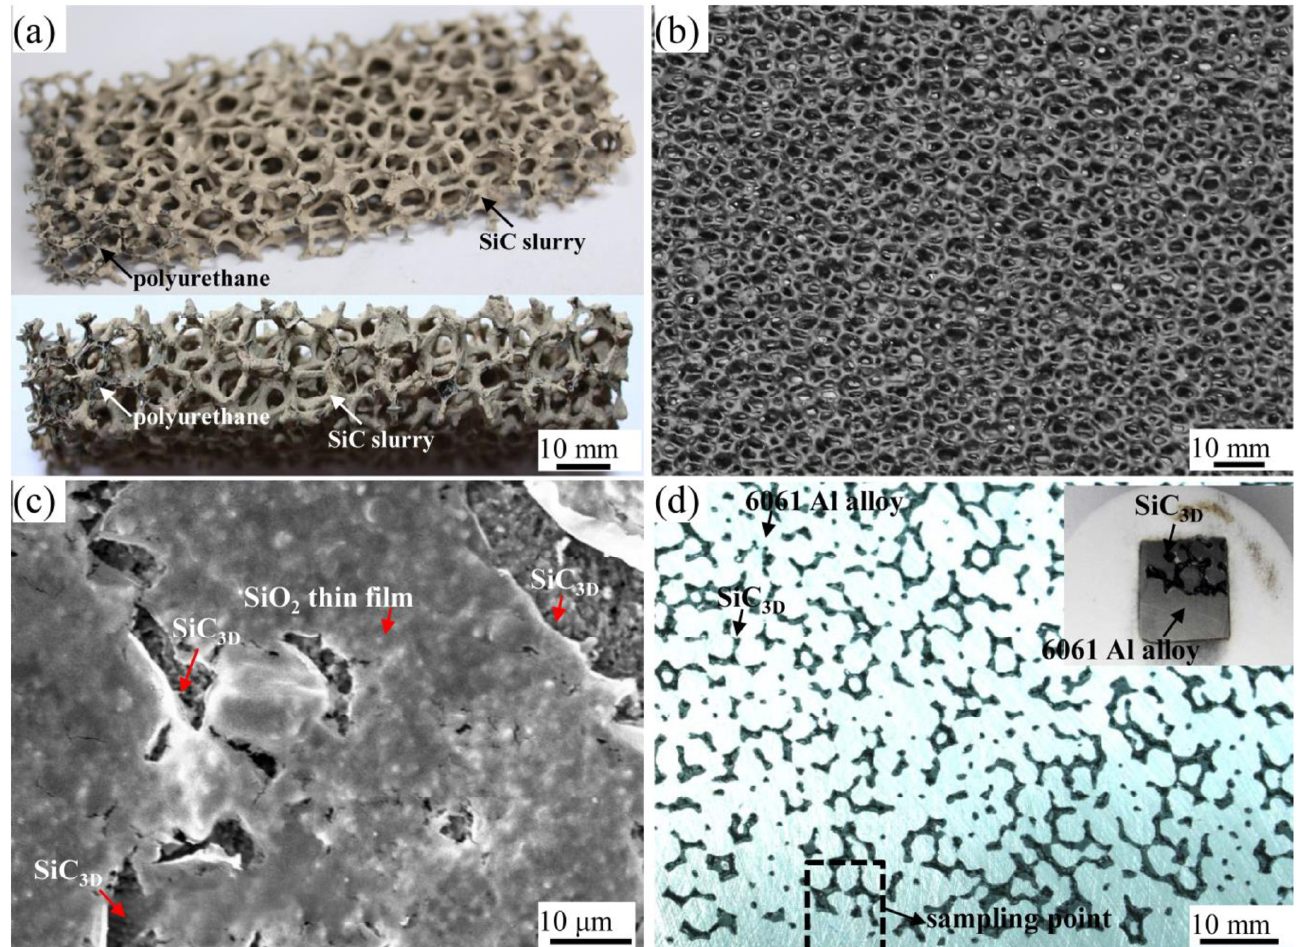
Figure 1. ( a ) Green SiC 3D skeletons; ( b ) sintered SiC 3D skeletons; ( c ) SiO 2 thin film was formed on the SiC 3D skeletons; ( d ) sampling points of SiC 3D /6061Al.